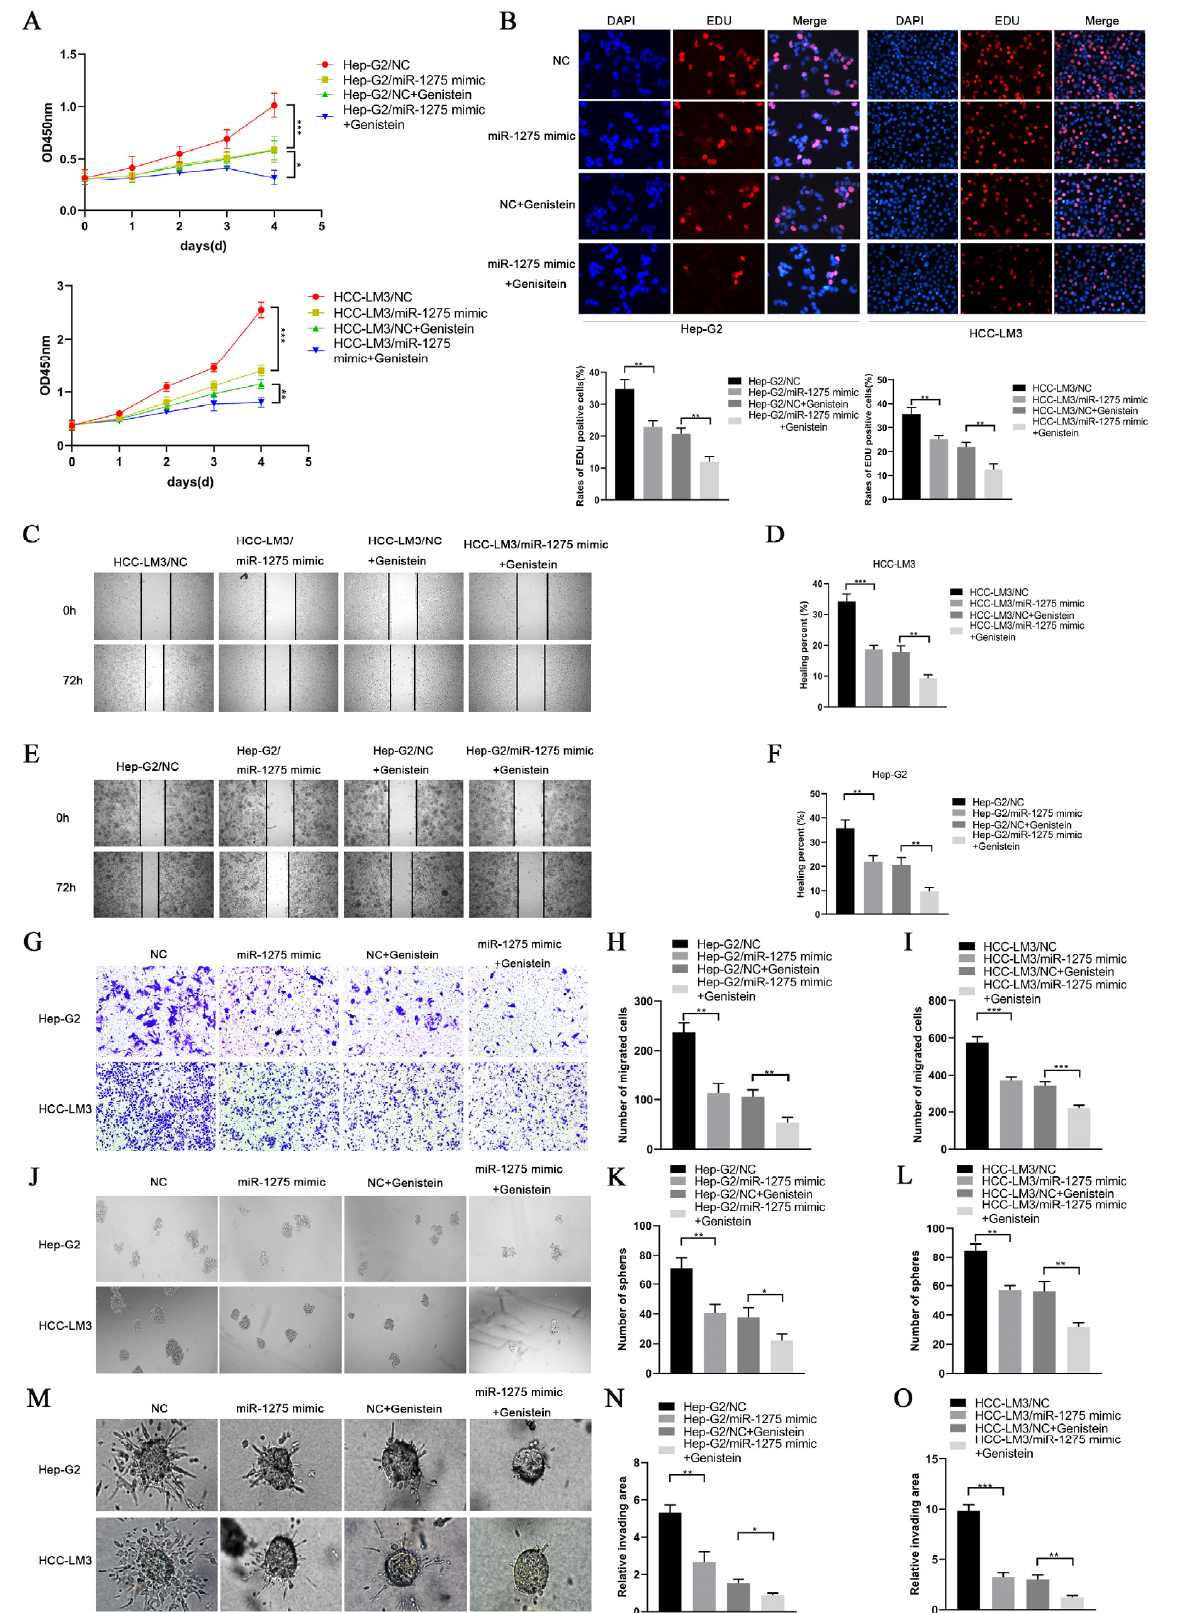
Figure 2. MiR-1275 upregulated by genistein inhibited the progression of HCC cells in vitro. ( A ) CCK-8 assays for evaluating the proliferation of Hep-G2 and HCC-LM3 cells in four groups: NC, miR-1275 mimic, NC + genistein and miR-1275 mimic + genistein. ( B ) EDU assays for assessing the proliferation of Hep-G2 and HCC-LM3 cells in the above four groups. DAPI (blue) represents all cells; EDU (red) represents proliferative cells. ( C – F ) The scratch-healing tests for assessing the mi- gration of Hep-G2 and HCC-LM3 cells in the above four groups. The vertical lines on both sides in the images represent the boundaries of the scratch. ( G – I ) Transwell migration assays for evaluating the migration of Hep-G2 and HCC-LM3 cells in the above four groups. ( J – L ) The spheroid formation tests for assessing the stemness of Hep-G2 and HCC-LM3 cells in the above four groups. ( M – O ) 3D spheroid invasion assays for evaluating the invasion of Hep-G2 and HCC-LM3 cells in the above four groups. Plotted values representing the mean ± SEM from three independent assays are pro- vided in the images ( n = 3). (* p < 0.05, ** p < 0.01, *** p < 0.001.)